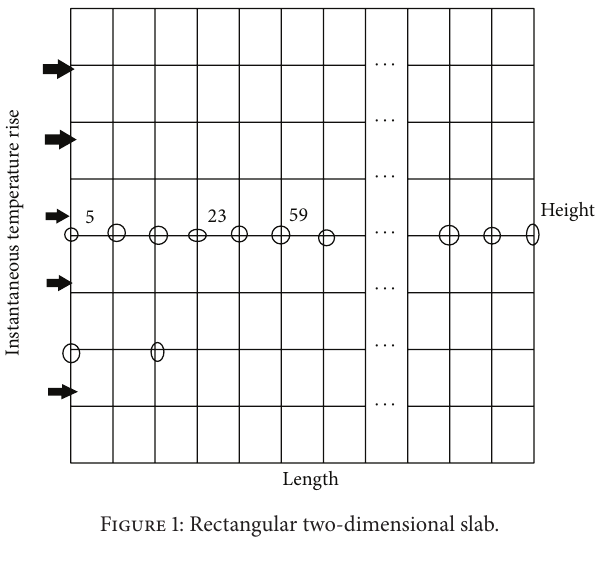
Figure 1: Rectangular two-dimensional